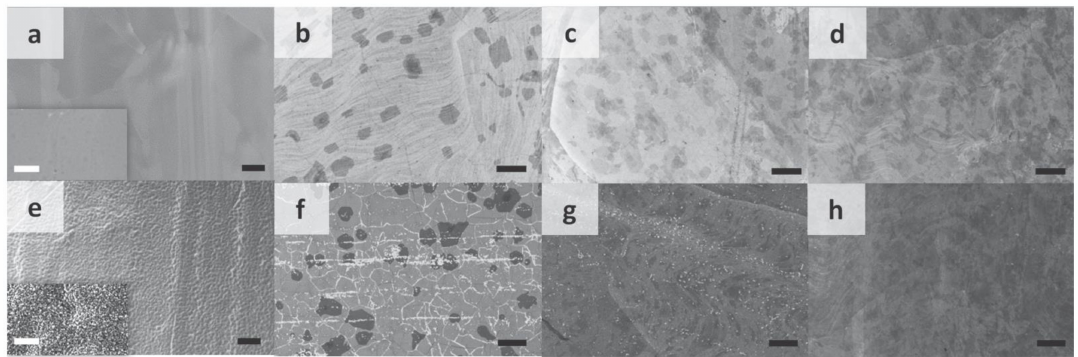
Figure 5. Scanning electron microscope (SEM) images comparing bare Cu, SLGx1_Cu (samples covered with layer of graphene), SLGx2_Cu, and SLGx4_Cu before ( a – d , respectively) and after ( e – h , respectively) 240 min of annealing in air at 200 ◦ C. Scale bars = 10 µ m. Insets in ( a ) and ( e ) depict SEM images of wider areas. Scale bars = 1 µ m. Reproduced from Roy et al. [139]. Copyright 2013 WILEY-VCH Verlag GmbH and Co. KGaA,